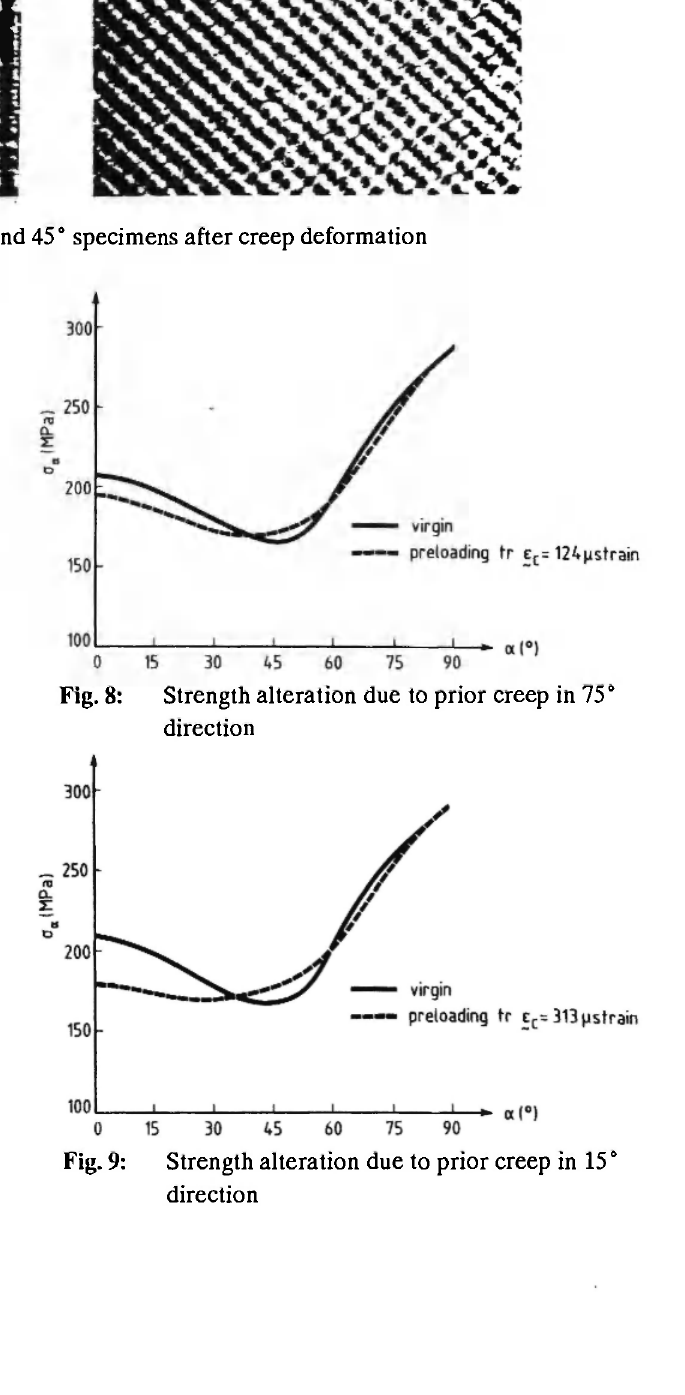
Fig. 9: Strength alteration due to prior creep in 15 °